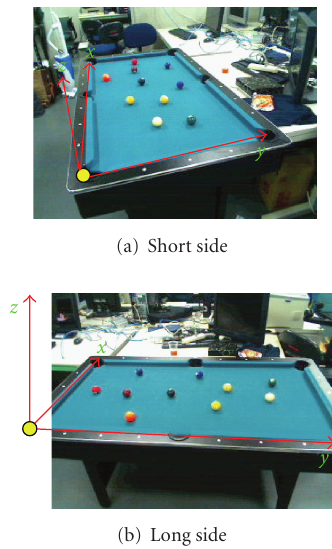
Figure 4: Definition of a world coordinate